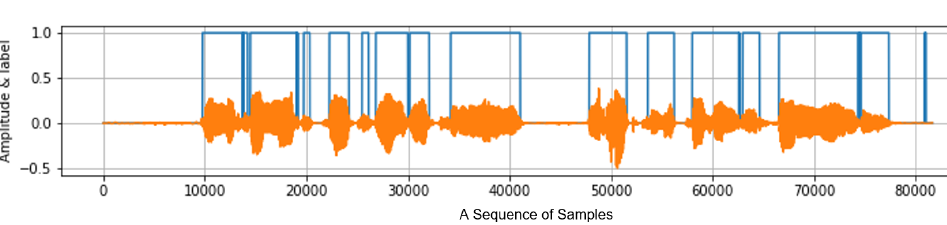
Figure 14. The result of fuzzy